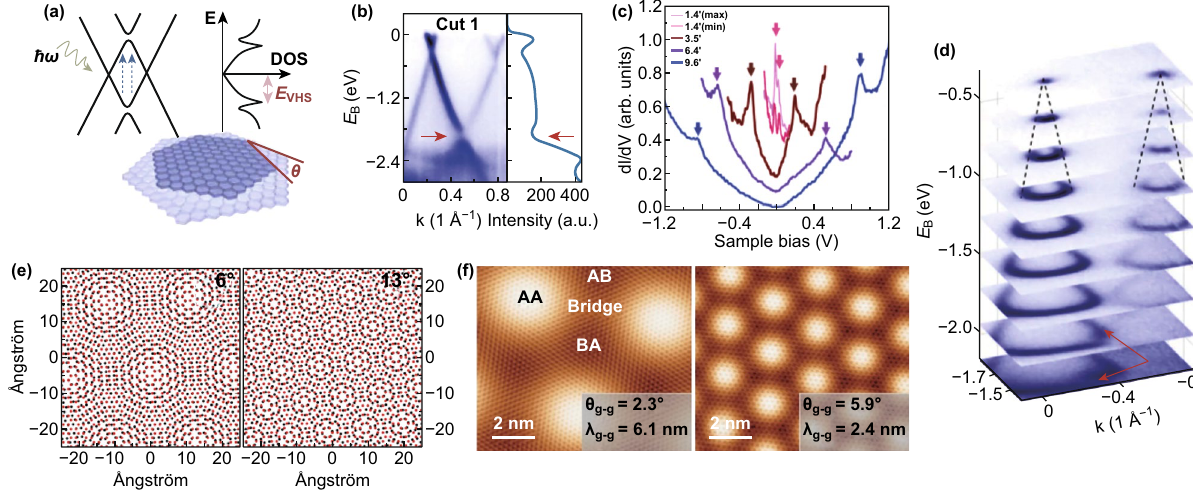
Fig. 2 a Schematics for band structure with mini-gaps and the corresponding density of state (DOS) with van Hove singularities (vHSs) in tBLG, b ARPES spectrum of tBLG [86]. c LDOS spectrum of moiré patterns with different twisting angles [98]. d Stacking plot of constant- energy contours at different binding energies of tBLG [86]. e Moiré patterns of tBLG with 6° and 13° twisting angle [99], f STM images of tBLG with 2.3° and 5.9° twisting angle [100]. Adapted with permission from Refs. [86,